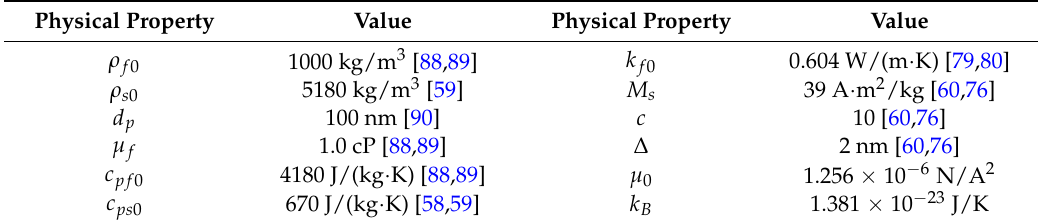
Figure 2. Illustration of the two physical problems: ( a ) heat conduction of a stationary nanofluid situated between two concentric cylinders; ( b ) unsteady flow over three cylinders in a rectangular channel. For both problems, a uniform external magnetic field is applied. Table 2. Physical properties of the water based Fe 3 O 4 nanofluid studied in the present study.